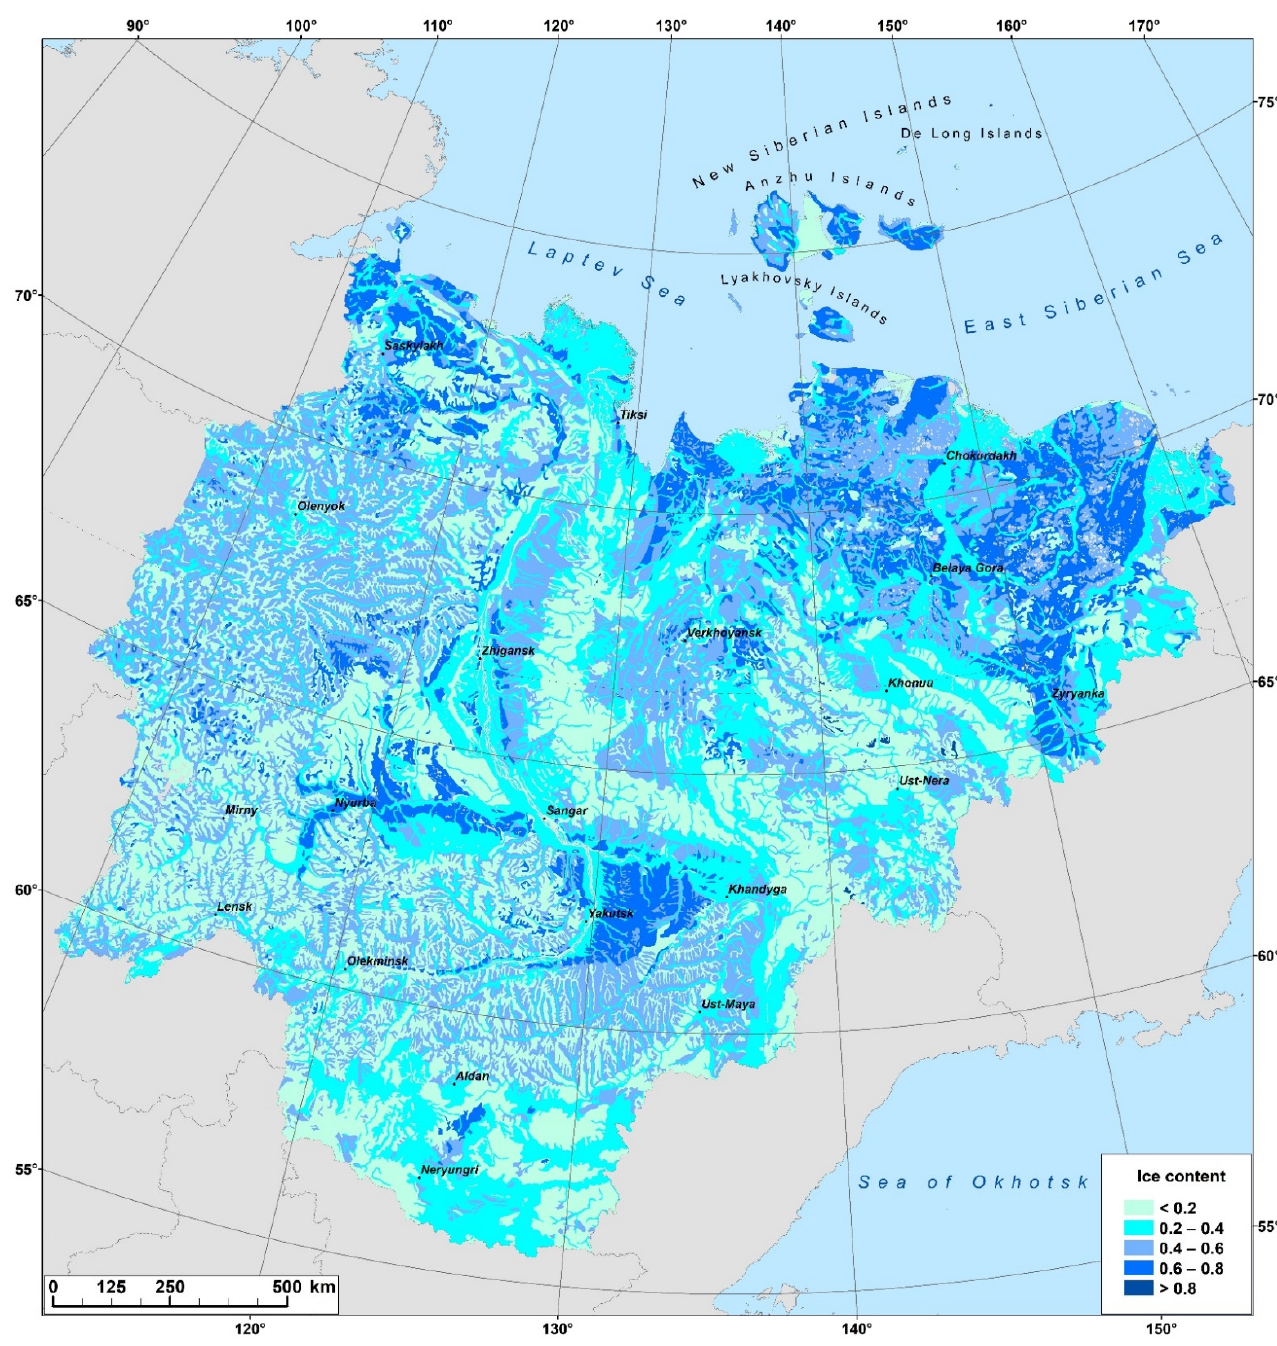
Figure 2. Ice content of surface deposits map [55] based on the permafrost landscape map of the Republic of Sakha (Yakutia) on a scale of 1:1,500,000 [51]. Republic of Sakha (Yakutia) on a scale of 1:1,500,000